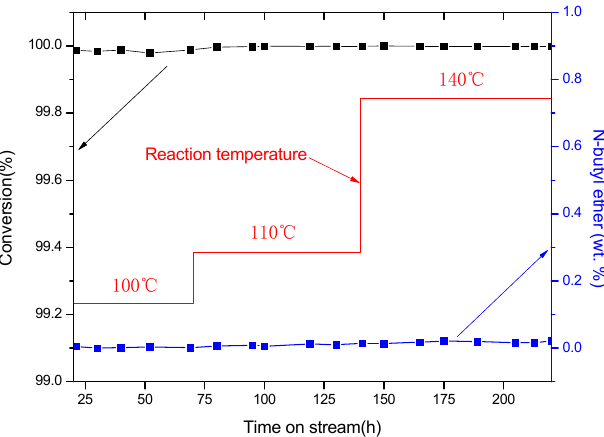
Figure 4. Long-term catalytic test for the Raney Ni/PA catalyst under a pressure of 4.0 MPa at different temperatures over 100–140 °C; red stepwise lines represent the temperature sequence used for the test [19]. Reproduced from Ref. [19] with permission from the Royal Society of Chemistry.